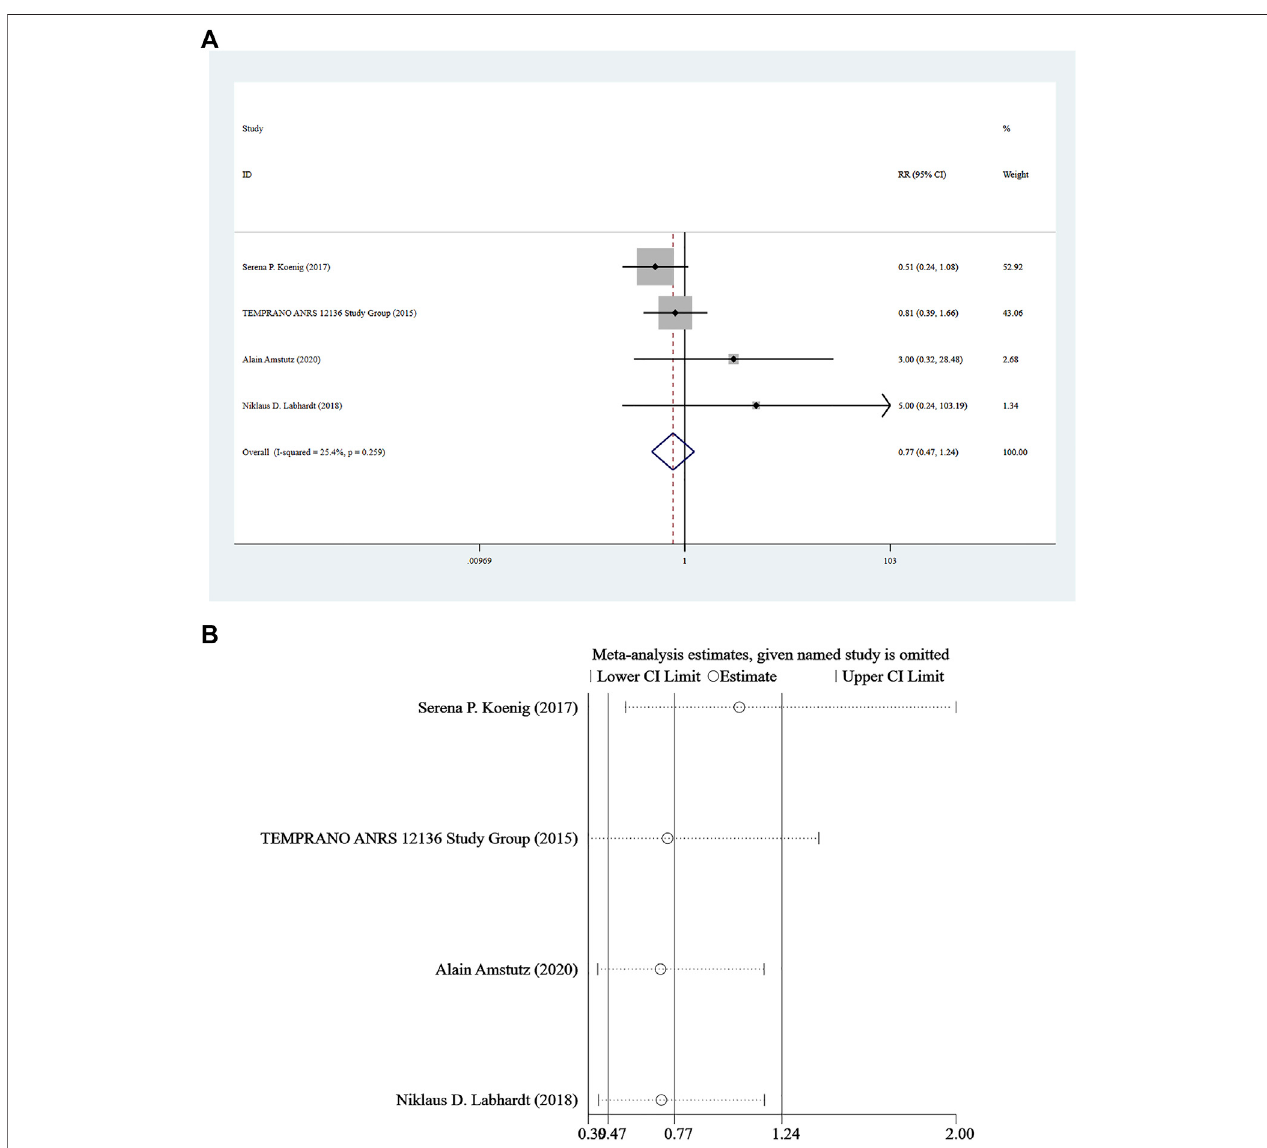
FIGURE5|(A) ForestplotforMeta-analysisofmortalitychart. (B) Sensitivityanalysisofmortalitychart(Afterremovingtheliteraturesonebyone,thecirclesofeach study were within the two edges, indicating that the conclusions of this meta-analysis were stable and reliable).